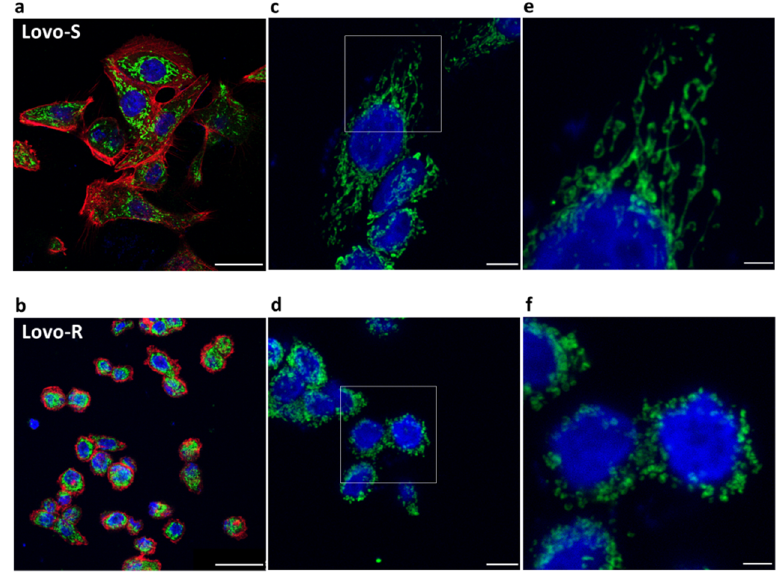
Figure 1. Confocal microscopy of LoVo-S and LoVo-R mitochondria. Representative photomicrographs of LoVo-S ( a , c , e ) and LoVo-R ( b , d , f ) mitochondria. Mitochondria were marked with anti cyclophilin F antibody and analyzed by confocal microscopy. Phalloidin ( a , b ) and DAPI were utilized to visualize the actin filaments and the nuclei, respectively. Right panel: zoom of the white square. Scale bar: 25 µ m ( a , b ), 8 µ m ( c , d ) and 3 µ m ( e , f ).